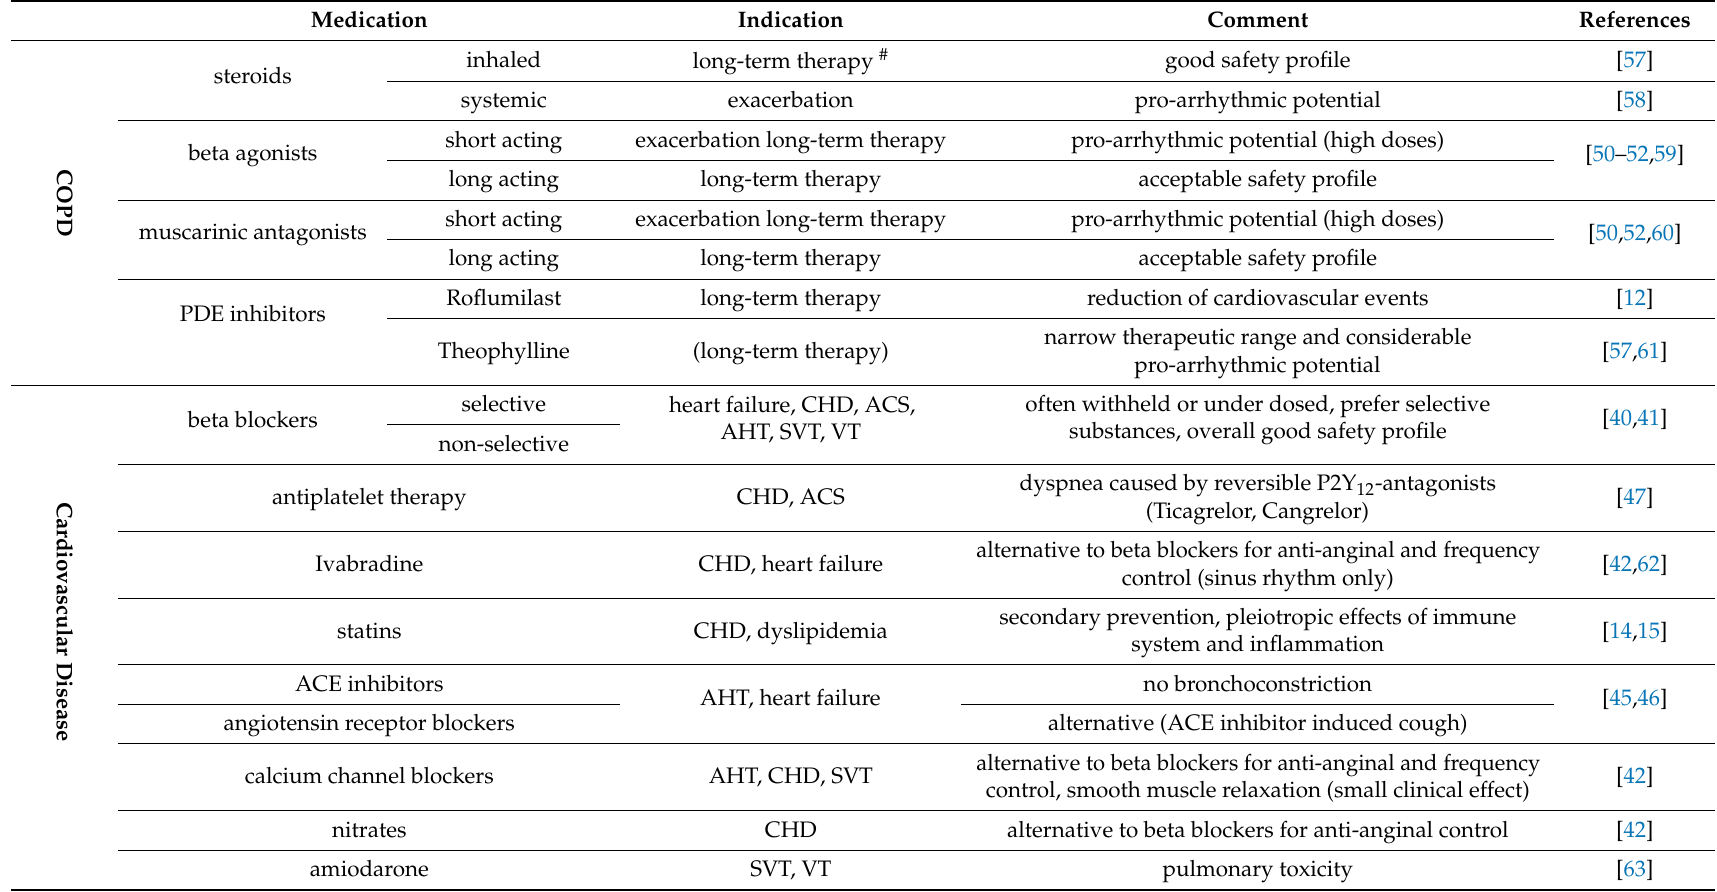
Table 1. Frequently used medication in COPD and cardiovascular